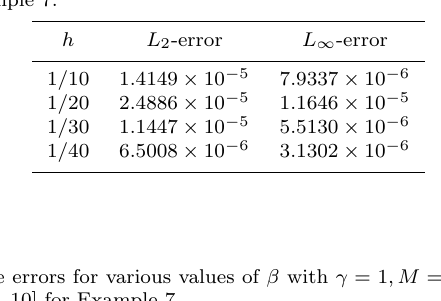
Table 10. Absolute errors for various values of β with γ = 1 ,M = N = 3 and h = 1 the interval [0 , 1] × [0 , 10] for Example 7. ( x,t ) β = 0 . 25 β = 0 . 5 β = 0 . 75 β = 1 (0 . 1 , 1) 9 . 5033 × 10 − 5 (0 . 3 ,